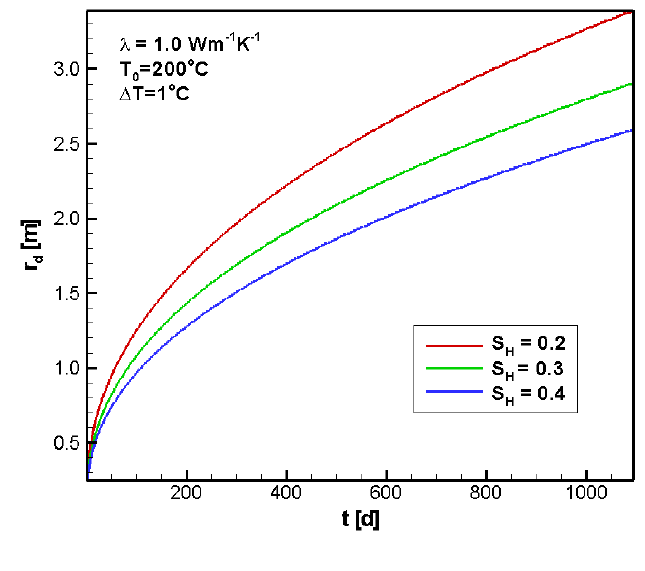
Figure 9. Evolution of hydrate dissociation radius and its sensitivity to hydrate